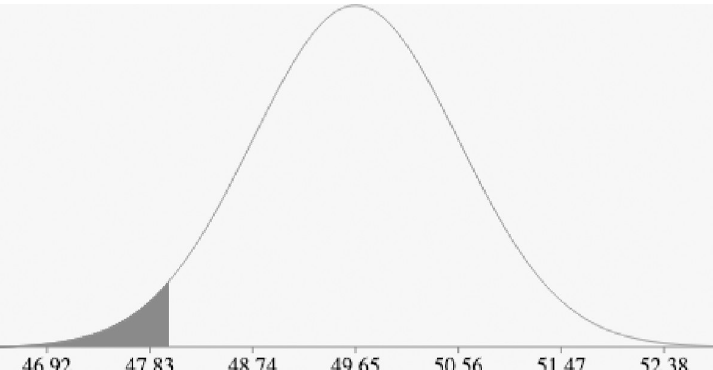
Fig 17. The normal distribution with mean 49.65 and standard deviation 0.91. Then P (X < 48; X < min g(X)) = 0.0349.